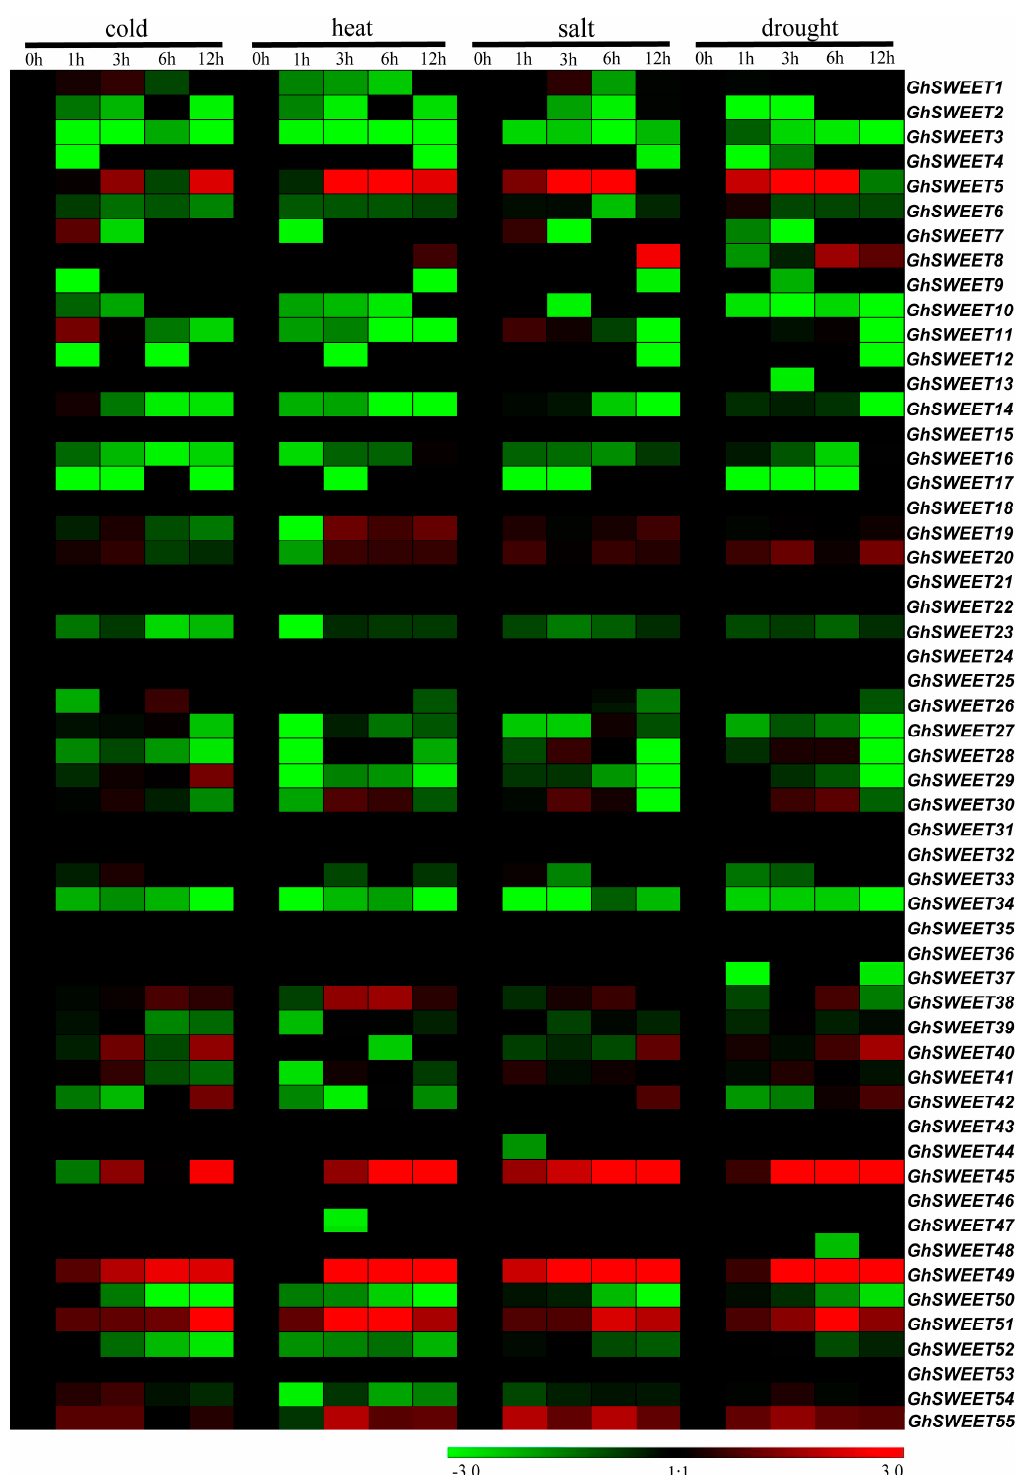
Figure 6. Expression patterns of GhSWEET genes in response to various stresses. The ratios of FPKM between treatments (at 1, 3, 6 and 12 h) and controls (at 0 h) were calculated by RNA-seq data, and shown as a heat map. The colored bar represents the scale of the relative expression levels.